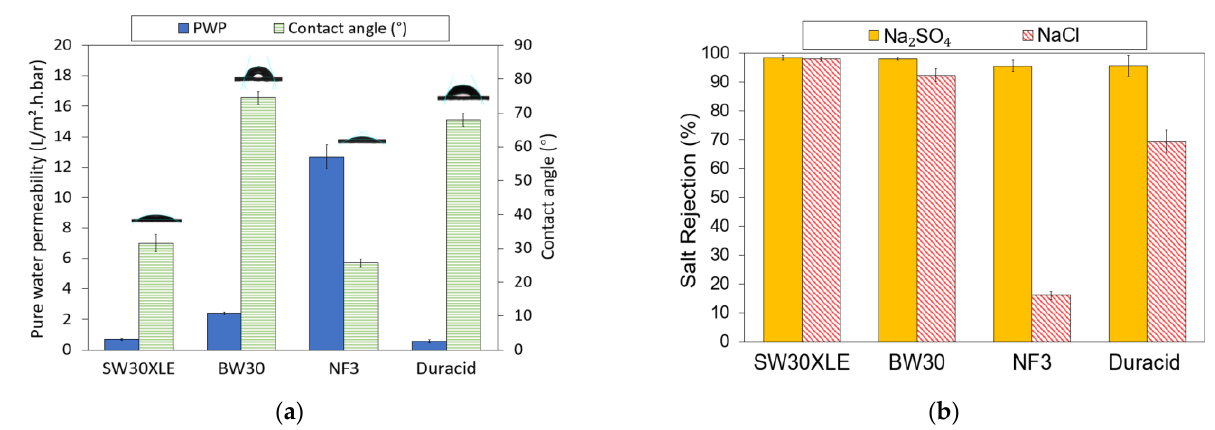
Figure 4. Properties of RO and NF membrane, ( a ) Pure water permeability (PWP) and water contact angle and ( b ) Monovalent and divalent salt rejection.